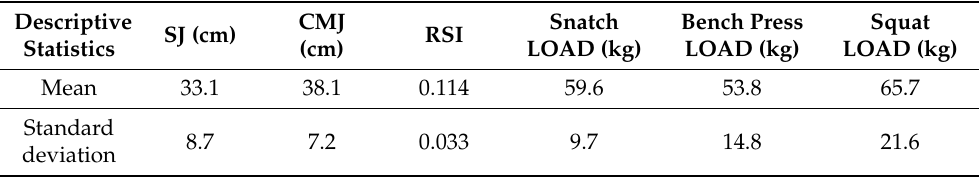
Table 4. Average values obtained in the tests included in the